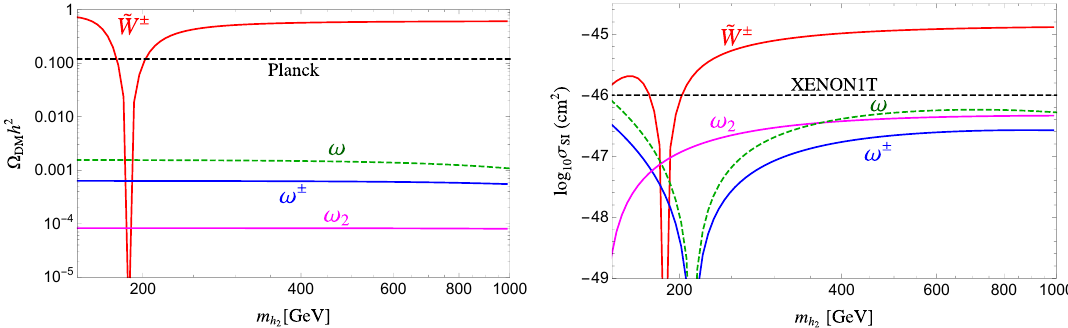
Figure 7. DM relic densities Ω DM h 2 (left) and the SI cross section σ SI (right) for the vector and scalar DM candidates versus m h . The dashed green lines are the scalar DM ω from the ST model. 2 The solid blue and magenta lines are the scalar DM ω ± , ω 2 from the TT model, respectively. The solid red lines are from the vector DM ˜ W ± . The dashed horizontal lines indicate the current bounds from PLANCK (left) and XERNON1T (right), respectively. The other parameters are fixed as BM1 in table